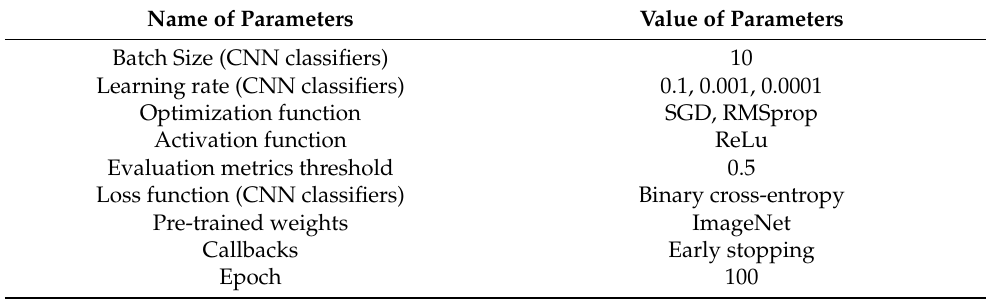
Table 3. Details of hyper-parameters.